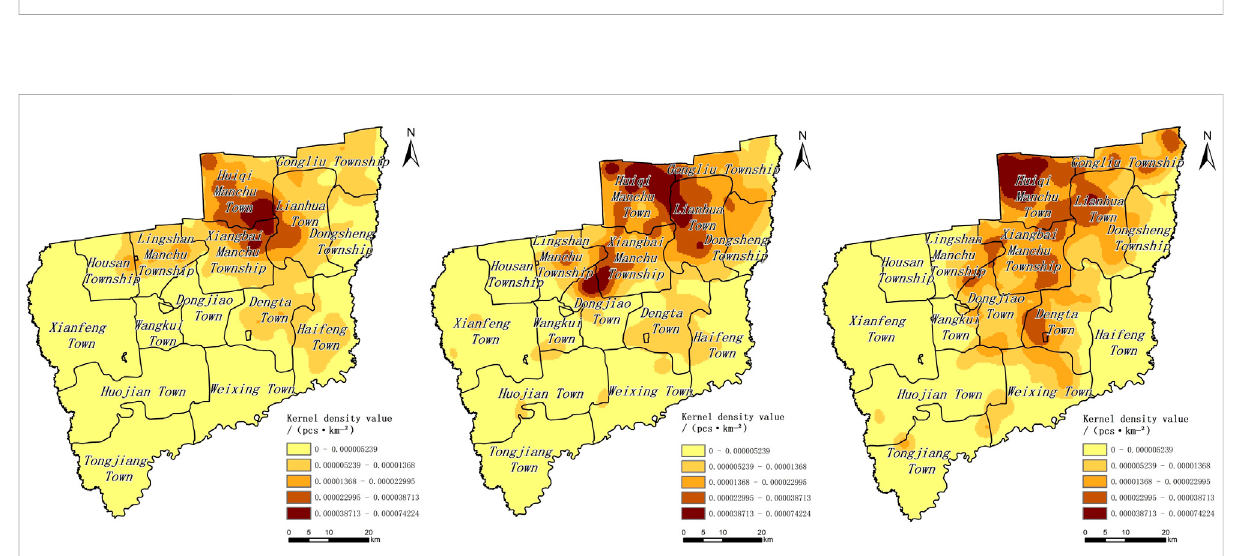
FIGURE 7 Spatial distribution characteristics and evolution of soybean continuous-cropping